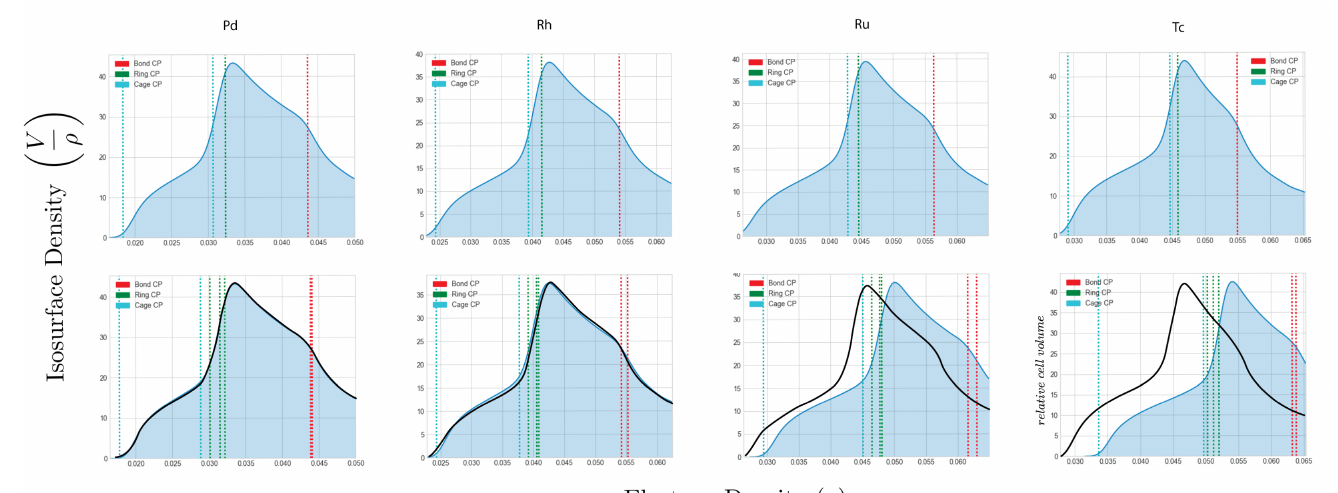
Figure 11. In normalized units the relative fraction of the Wigner–Seitz cell occupied by a given density, i.e., the cell isosurface density, accompanying an FCC to HCP transformation. The top row shows the electron density distribution of the FCC structure and the second row is the distribution of the HCP structure. The normally FCC metals Rh and Pd experience very little charge redistribution through the transformation. For the normally HCP metals, however, charge is observed to be transferred to the bonds and rings of the shared tetrahedral–octahedral faces, making the electron density in the octahedral cage steeper and hence increasing its kinetic energy. Isosurface density may be regarded analogous to a real space DOS partitioning, created by counting the voxels within the Wigner–Seitz cell with a given value of density. The small tails which lie at densities below the cage CPs are fitting